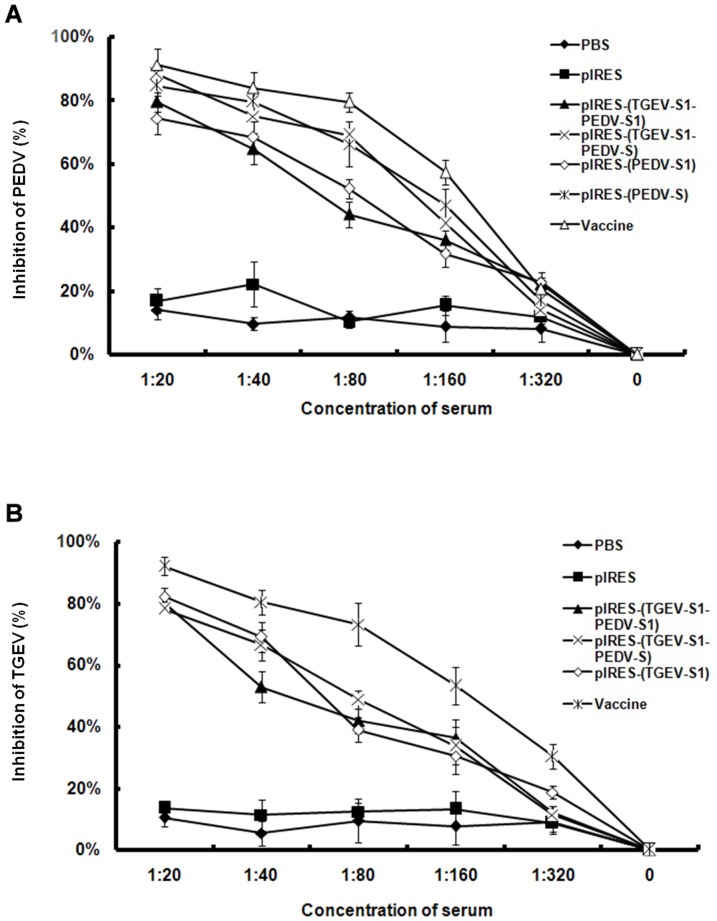
Levels of neutralizing antibodies in mice treated with pIRES-(TGEV-S1-PEDV-S1) and pIRES-(TGEV-S1-PEDV-S).Anti-PEDV and anti-TGEV neutralizing antibodies in immunized mice were detected by plaque reduction assay with different serum dilutions from blood samples taken at 28 days after the injection of the plasmid DNAs.